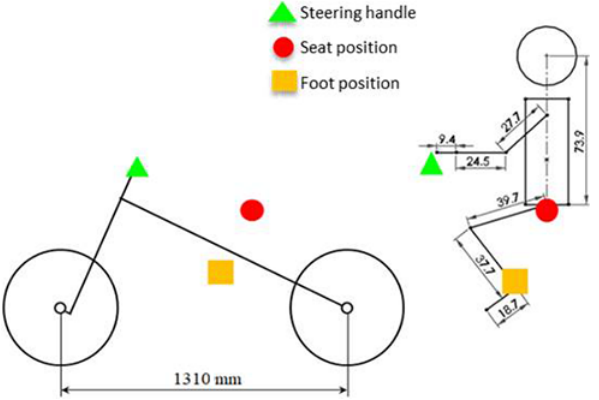
Figure 2. Vehicle body geometry configuration.